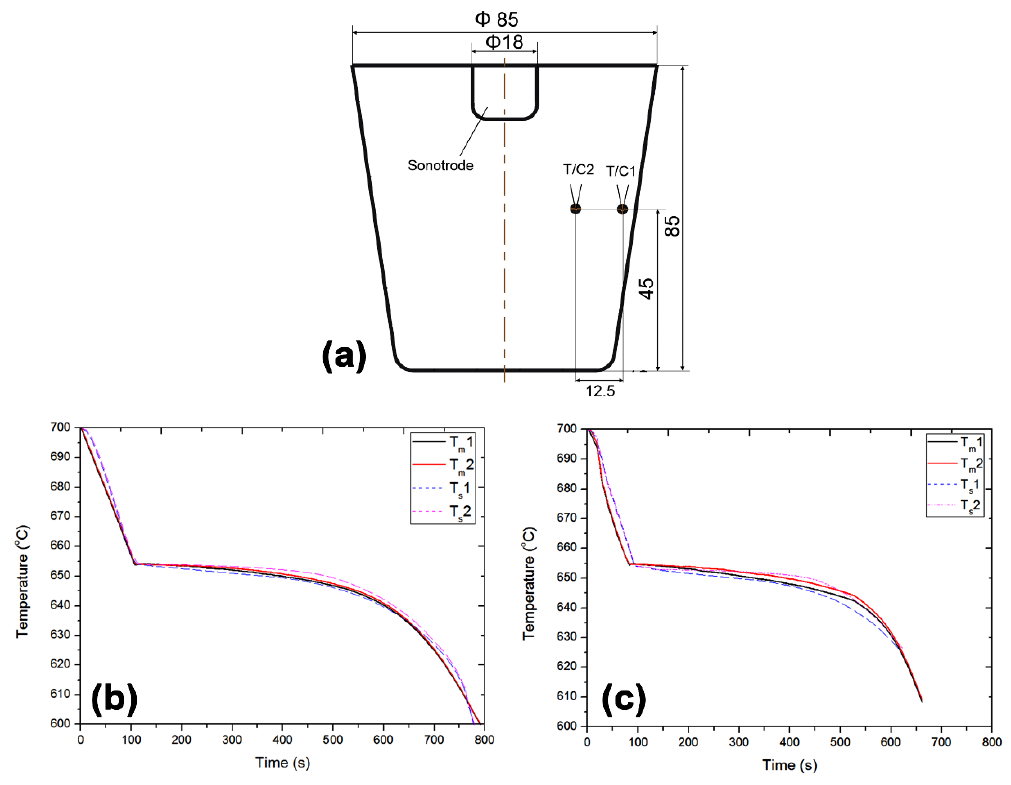
Figure 2. ( a ) Schematic of the casting setup with two thermocouples for the validation of the model and the corresponding cooling curves in ( b ) as-cast condition without UST and ( c ) after UST [38].